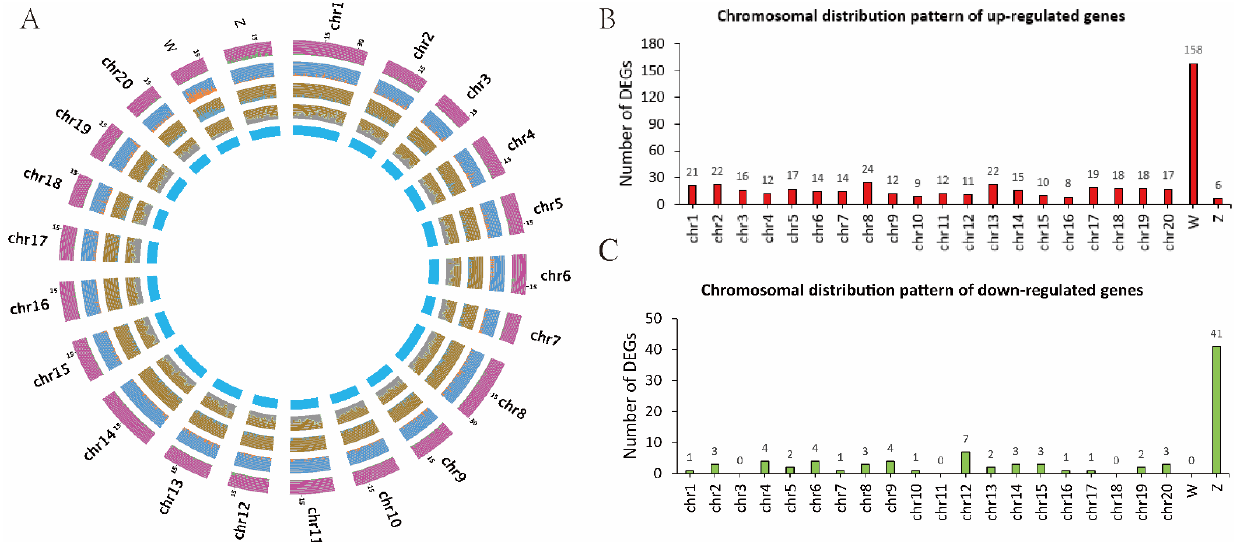
Figure 2. The chromosomal distribution of DEGs from sperm transcriptomes. ( A ) The circus plot of the genome features. From outer to inner: A distribution of downregulated genes; B, distribution of upregulated genes; C, distribution of DEGs; D, gene density; E, representing the 24 chromosomes. ( B ) The number of upregulated DEGs on each chromosome. ( C ) The number of downregulated DEGs on each chromosome.